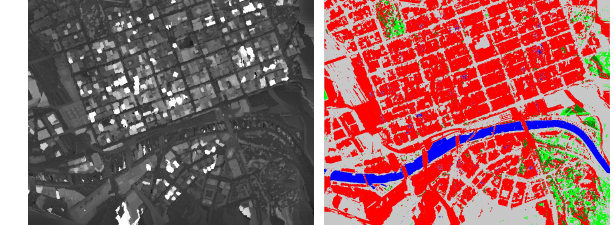
Figure 13. Normalized heightmap and fitting final classification, 2500 m × 2000 m, red: buildings, dark green: trees, green: grass, blue: water, brown: soil, gray: roads/sealed